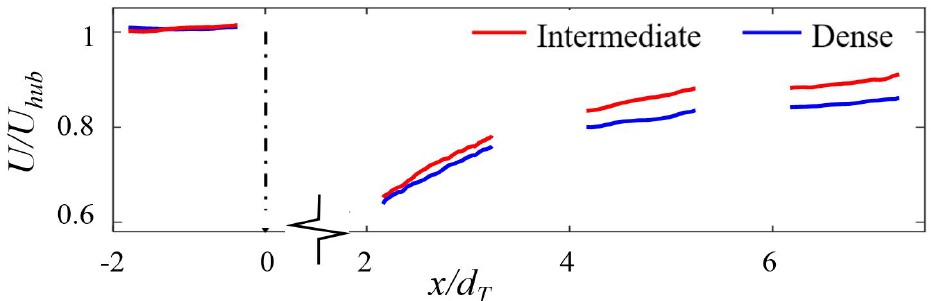
Figure 6. Non–dimensional hub height streamwise velocity profiles, U / U hub , over the intermediate and dense forest